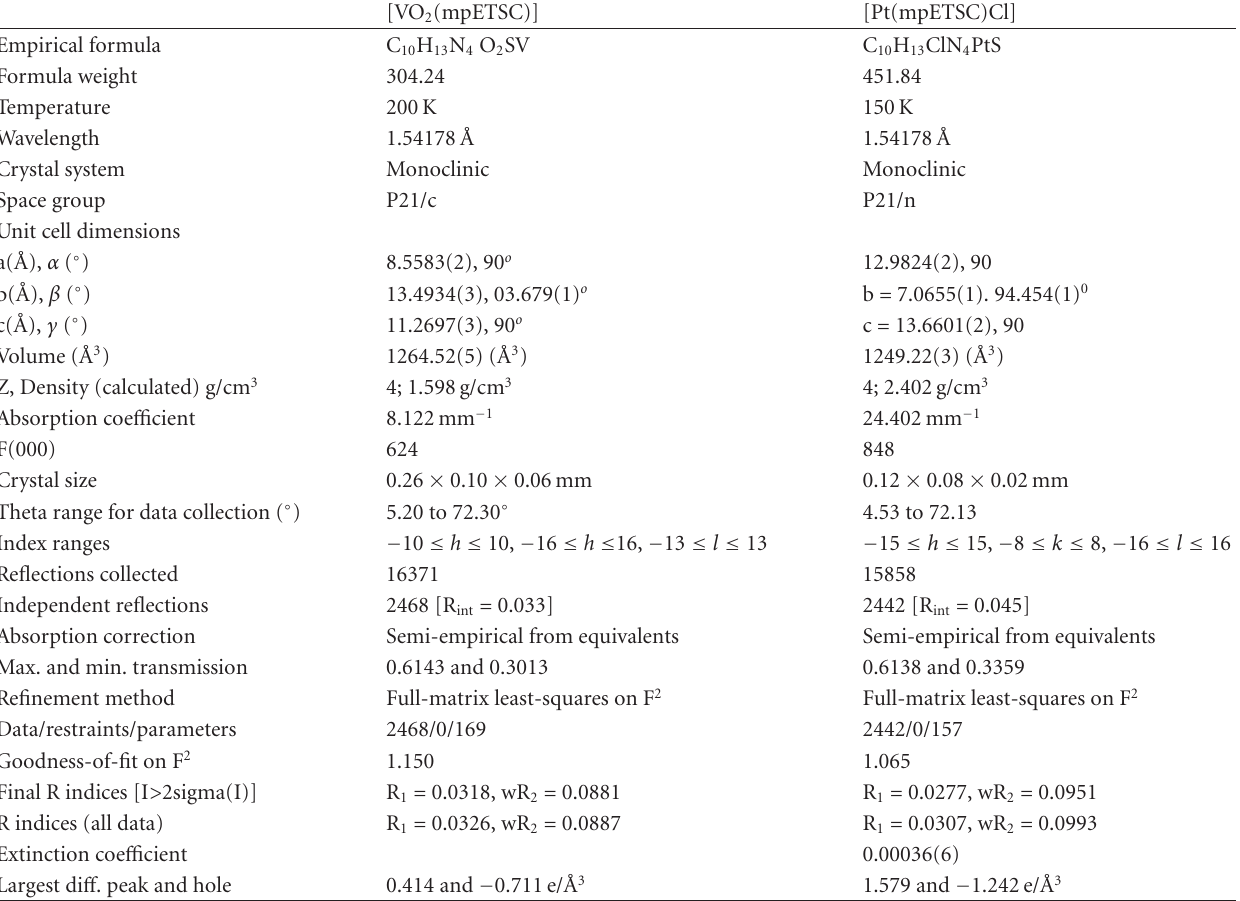
Table 1: Crystal data and structure refinement for VO 2 (mpETSC) and Pt(mpETSC)Cl.